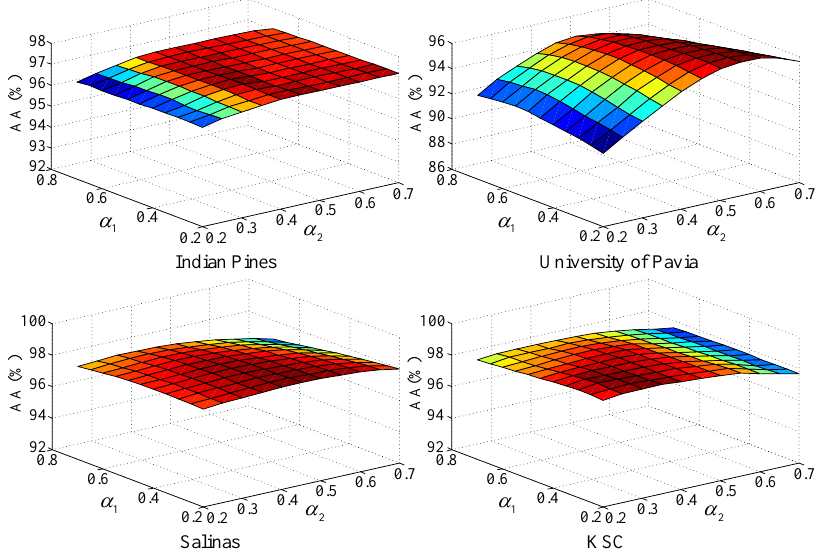
Figure 6. Effect of weighting parameters α 1 and α 2 on classification